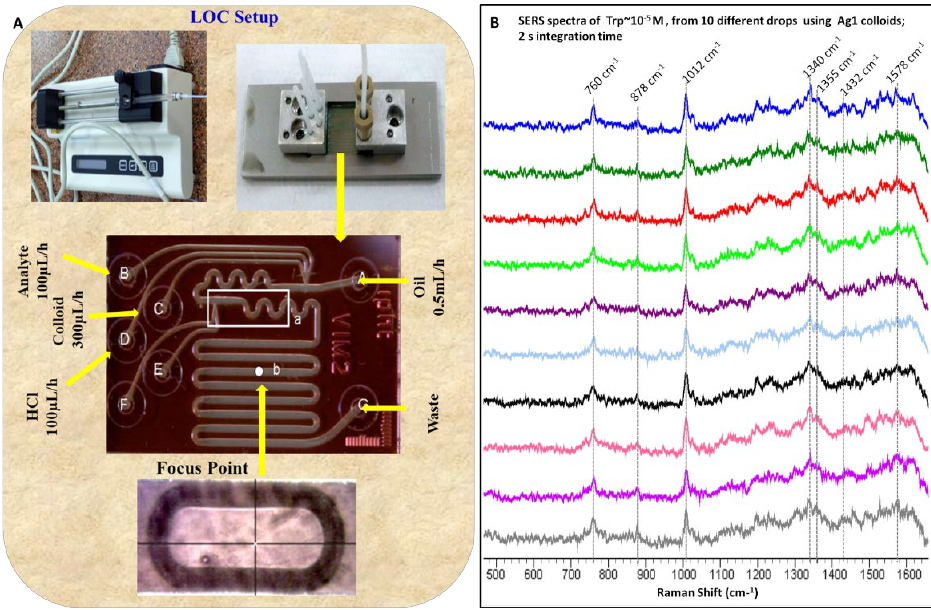
Figure 6. ( A ) schematic of the lab-on-a-chip (LOC) setup. ( B ) SERS spectra for Tryptophan using Ag1 colloids obtained with LOC system from ten different drops.